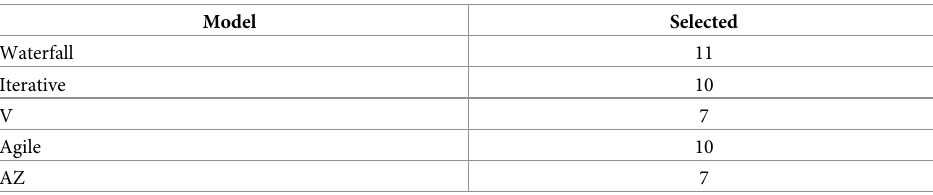
Table 4. Distribution of software development